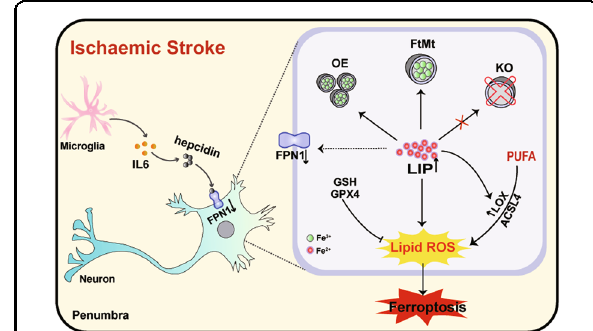
Fig. 8 Schematic representation of the proposed neuroprotective mechanism of FtMt following cerebral I/R. Ischaemic stroke causes in fl ammation and iron dysregulation in neurons, which results in increases in intracellular LIP levels. Free iron may promote the generation of L-ROS and subsequent ferroptosis in penumbral cells. FtMt can withdraw iron from the cytoplasmic pool and inhibit ferroptosis, thus in turn attenuating brain damage in